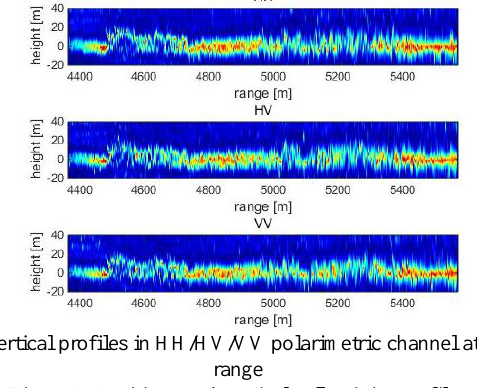
Figure 1. Positions and vertical reflectivity